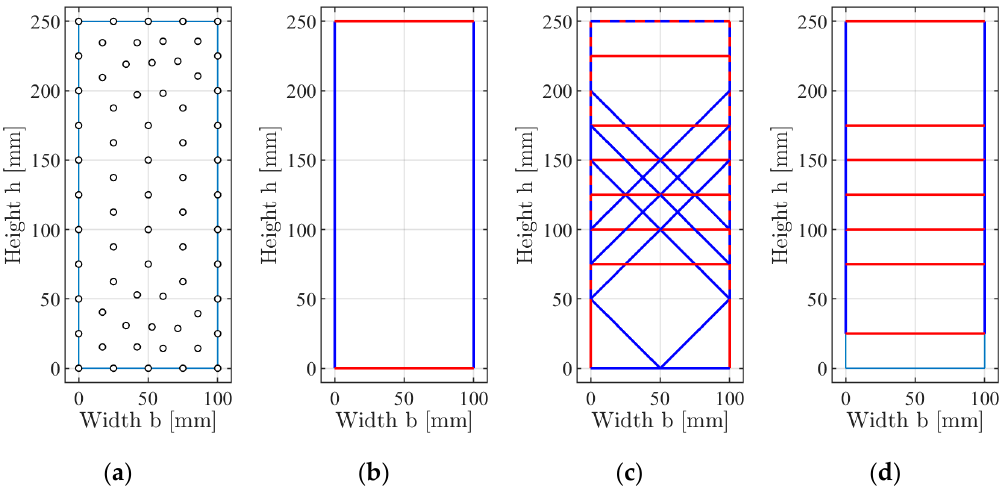
Figure 13. Collapse mechanisms (blue: Slip displacements, red: Normal displacements) for a specimen with a compression-only support at the bottom edge and a tension or compression force at the upper edge: ( a ) Nodes; ( b ) tension force; ( c ) compression force and T resca criterion; ( d ) compression force and M ises criterion.